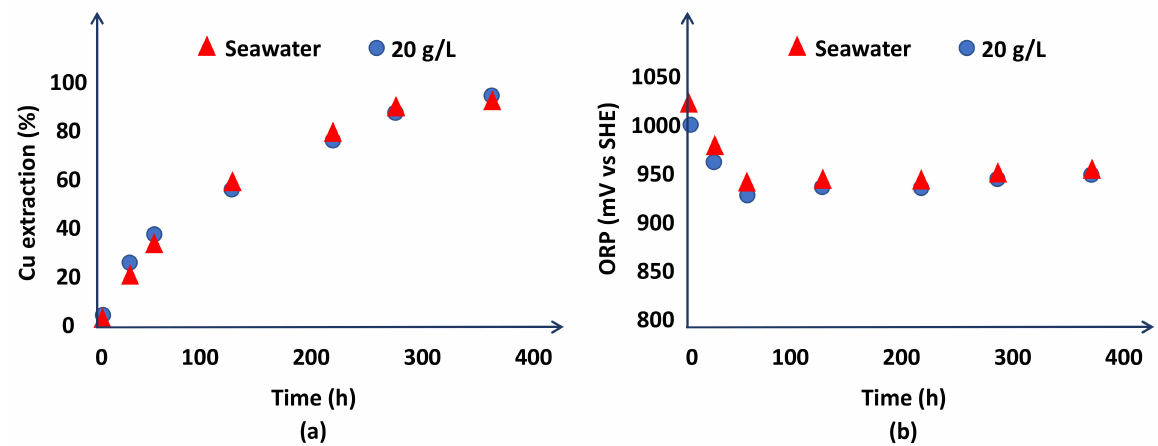
Figure 6. ( a ) Comparison of copper extraction (%) curve when seawater and water with 20 g/L Cl − were used as water sources in the leach solution. ( b ) Redox potential (mV) versus time (h) when seawater and water with 20 g/L Cl − were used as a source of water in the leach solution.